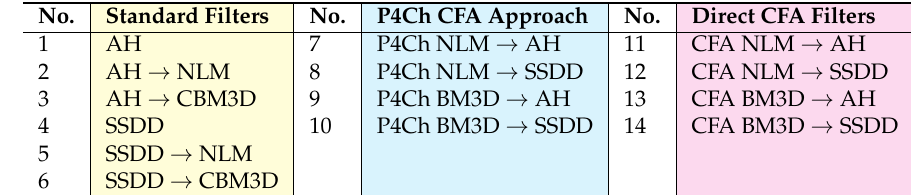
Table 1. Filtering and demosaicing scenarios used in our experiments divided into three groups. No.